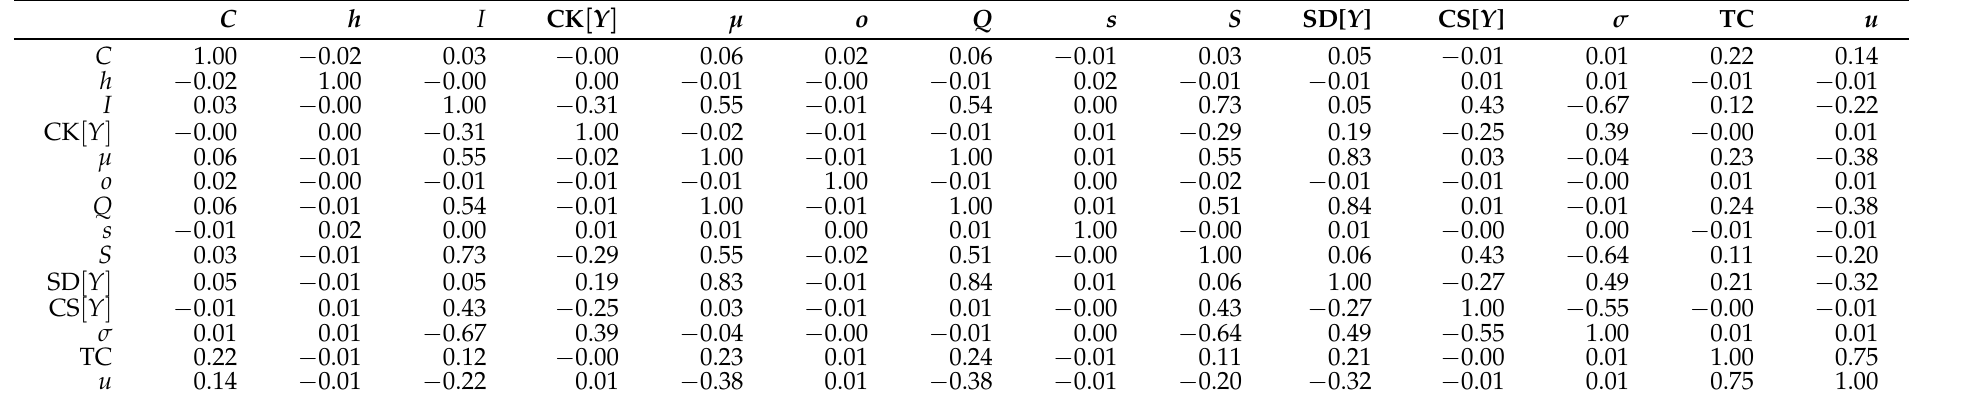
Table 6. Pearson correlation coefficient matrix between variables of the simulation